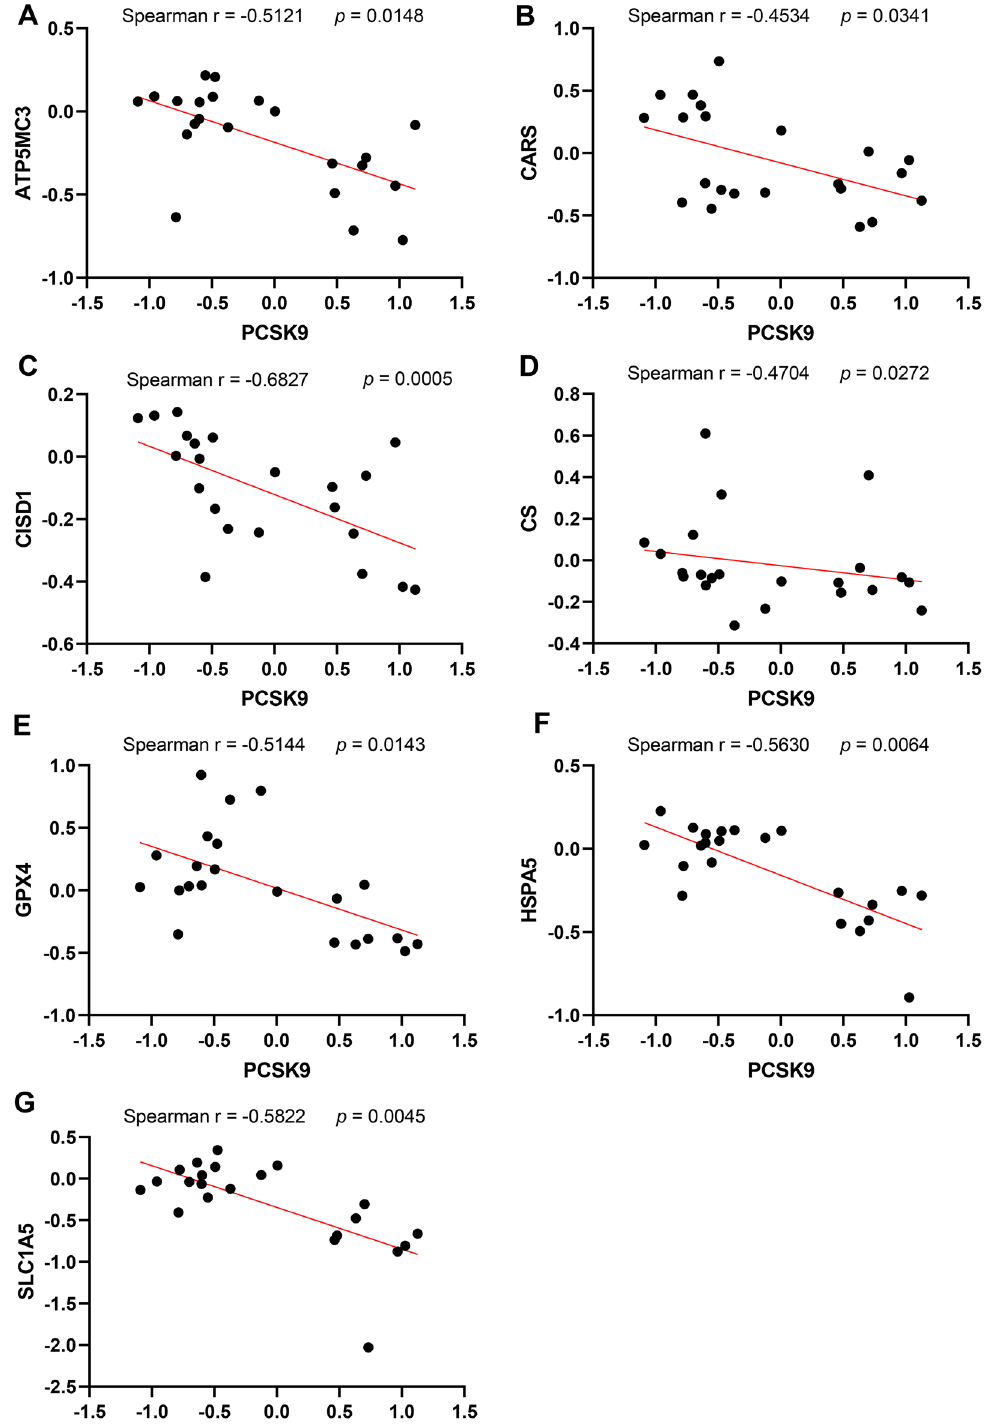
Figure 7. The correlation between PCSK9 and ferroptosis related genes in human AAA neck and normal tissues. Spearman’s correlation analysis of the expression data from GSE47472 from GEO database showed that PCSK9 was negatively related to ATP5MC3 (Spearman r = − 0.5121, p = 0.0148) ( A ), CARS (Spearman r = − 0.4534, p = 0.0341) ( B ), CISD1 (Spearman r = − 0.6827, p = 0.0005) ( C ), CS (Spearman r = −